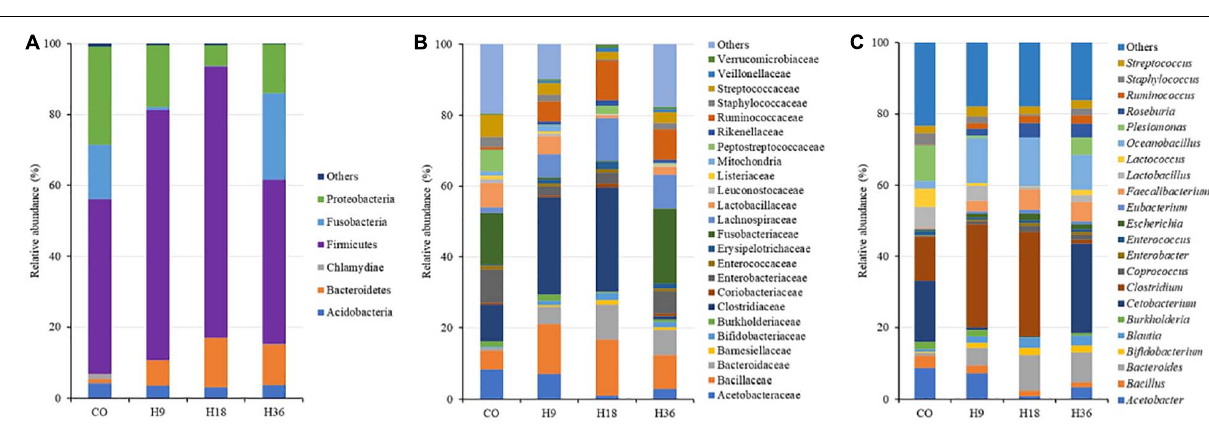
FIGURE 5 | Relative abundance (%) of the OTUs in the intestine of pikeperch fed experimental diets at phyla (A) , family (B) , and genus (C) level. Only bacteria with an overall abundance of ≥ 1% and ≥ 0.5% at phylum and family/genus level, respectively, were presented. The bacteria were pool as “Others,” when lower than aforementioned